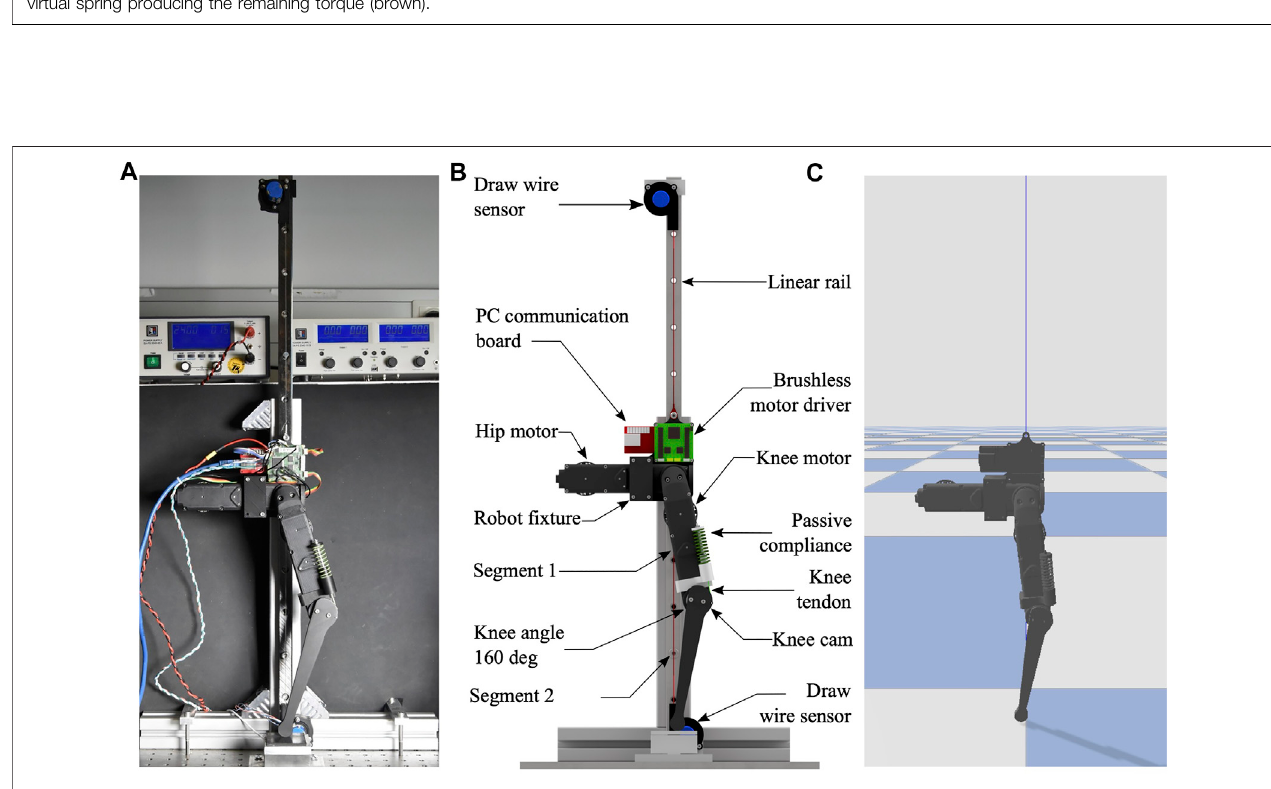
FIGURE3| Experimentalsetup. (A) The2-DOFhybridcompliantleg.Theone-directionalspring(passivecompliance)extendsthekneejointviaakneetendonand a knee pulley. Knee springs with varying stiffness were mounted during the experiments, supporting between 0 and 100% robot ’ s weight. A rail guides the robot ’ s vertical drop, and a pair of potentiometers measures the robot ’ s height. The knee motor produces torques in parallel to mounted knee spring. (B) Setup details, computer aided drawing. (C) The Uni fi ed Robot Description Format (URDF)-based model of the hybrid compliant robot leg, simulated in PyBullet.